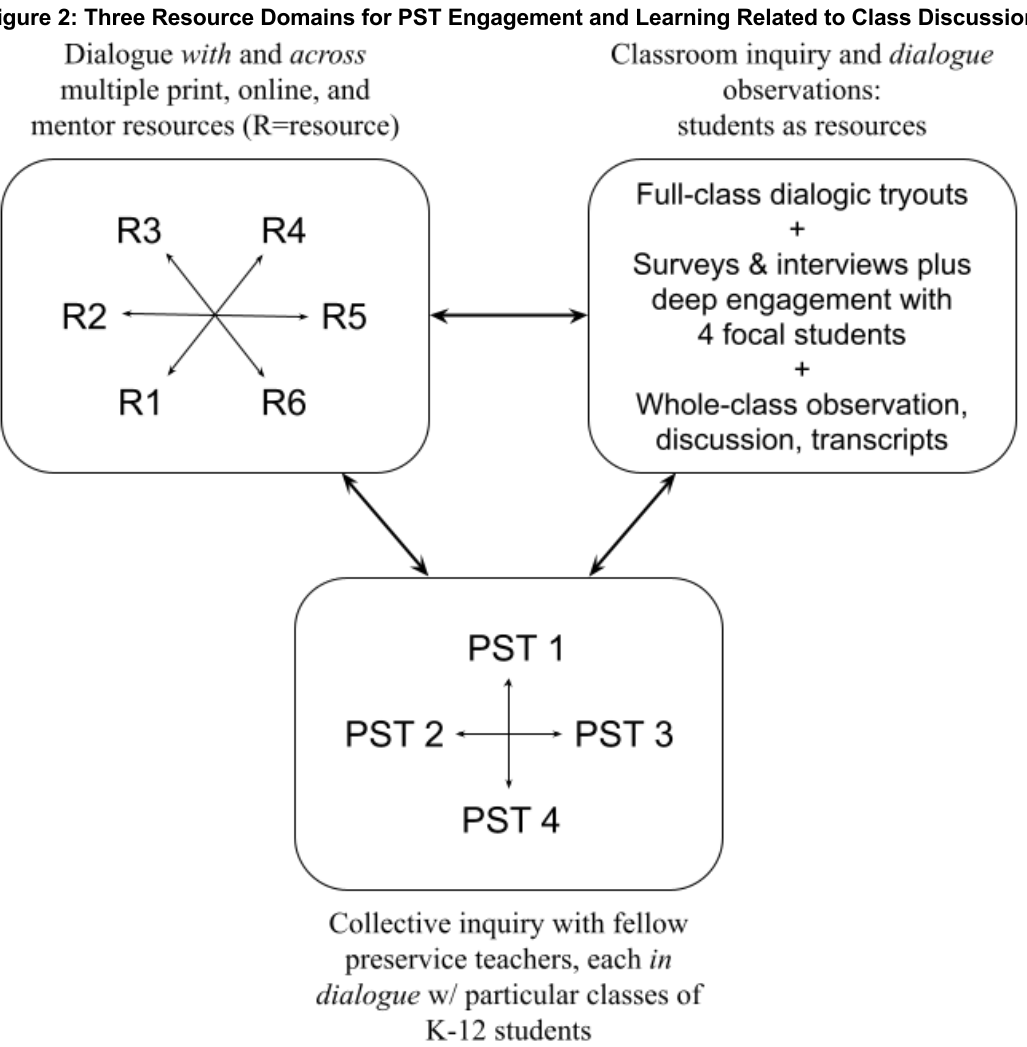
Figure 2: Three Resource Domains for PST Engagement and Learning Related to Class